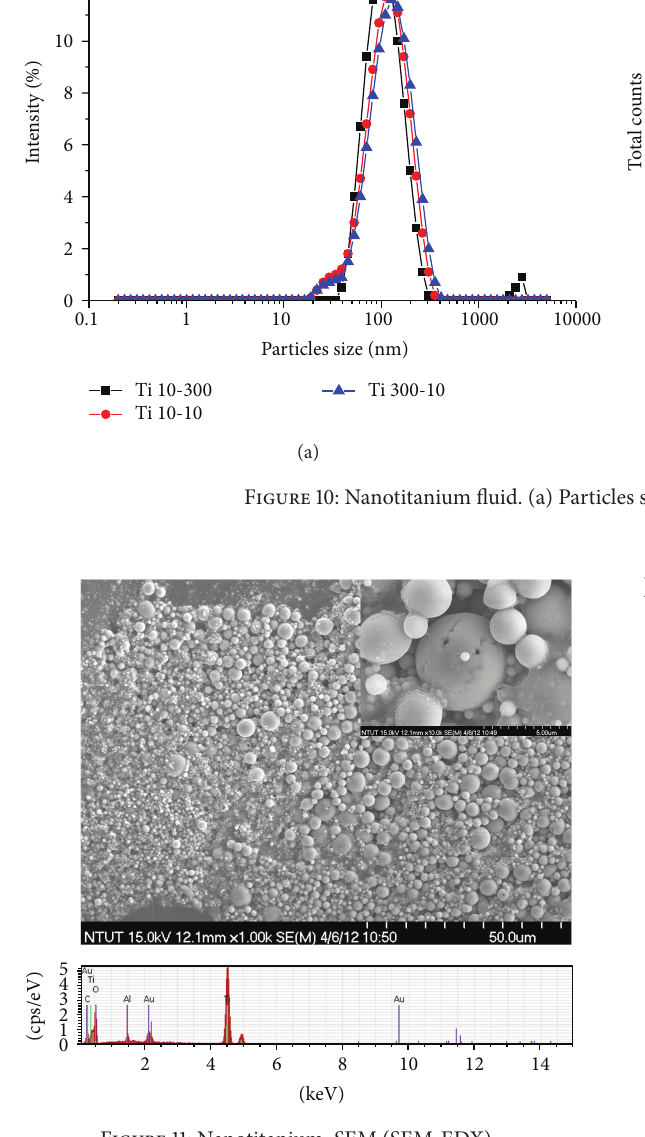
Figure 11: Nanotitanium, SEM